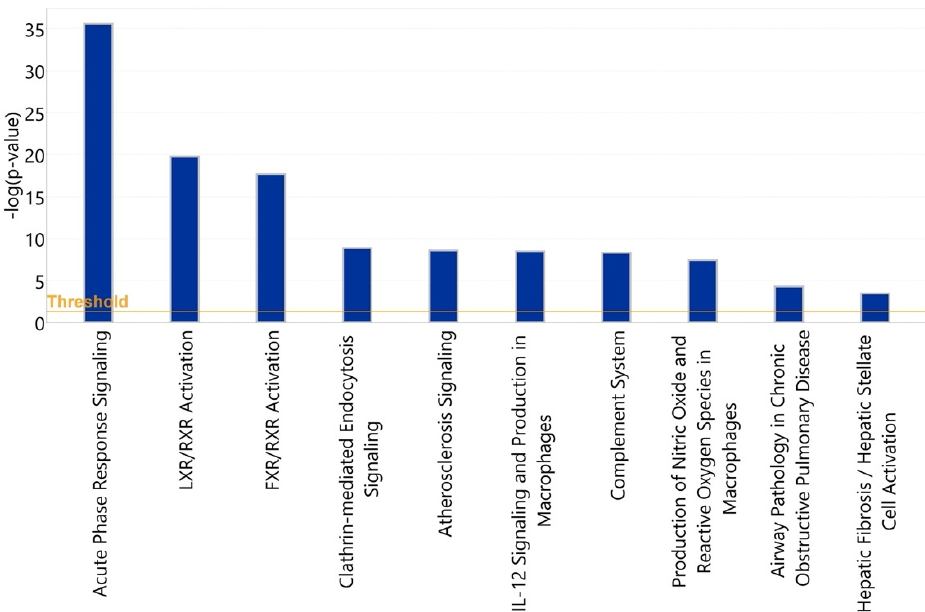
Figure 17. Statistical significance levels of differential activation of canonical pathways among nonsevere vs. severe COVID-19 cases. nonsevere vs. severe COVID-19